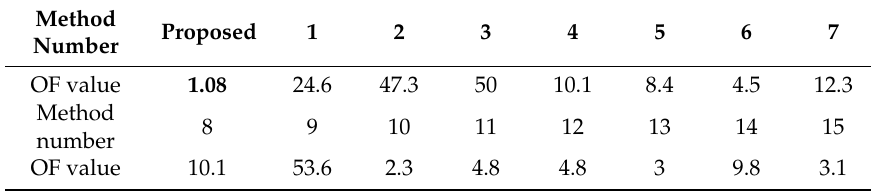
Table 7. Comparison of the proposed method with other techniques from literature in terms of OF.